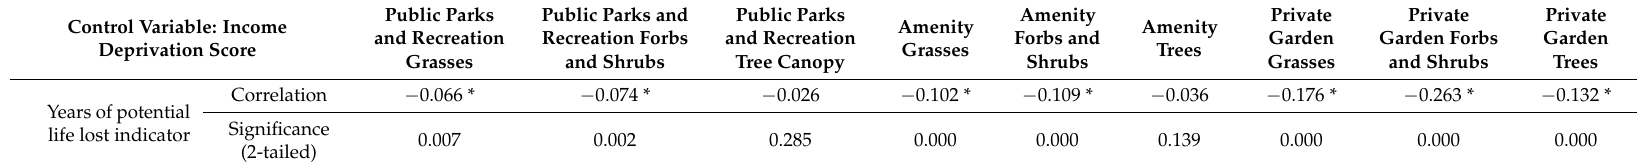
Table 2. Correlation matrix: selected ILM landscape features with years of potential life lost indicators. * denotes p < 0.05.